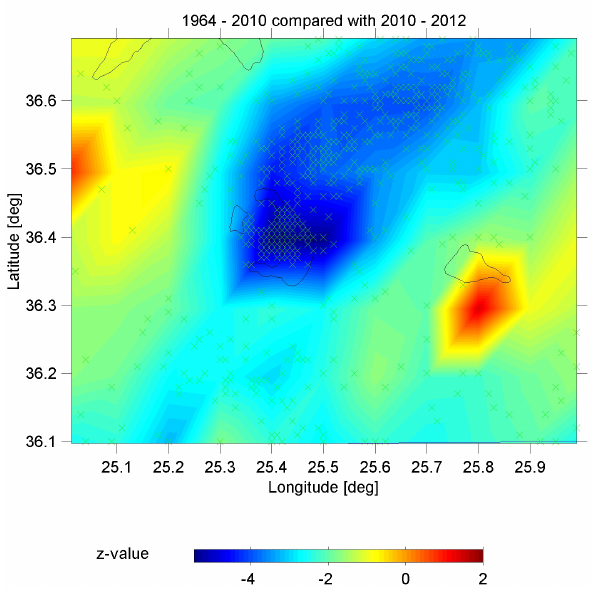
Fig. 5. Z-value map showing the rate changes after the recent pe- riod of detection increase. (note that negative z-values by definition indicate seismicity rate increases).